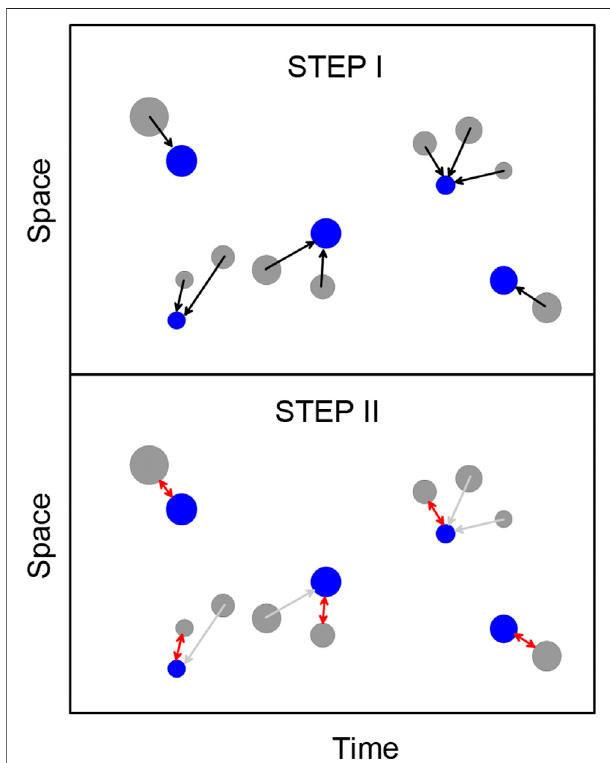
Figure 2B by red arrow. Other events are declared to be non- duplicates, regardless of the metric values.